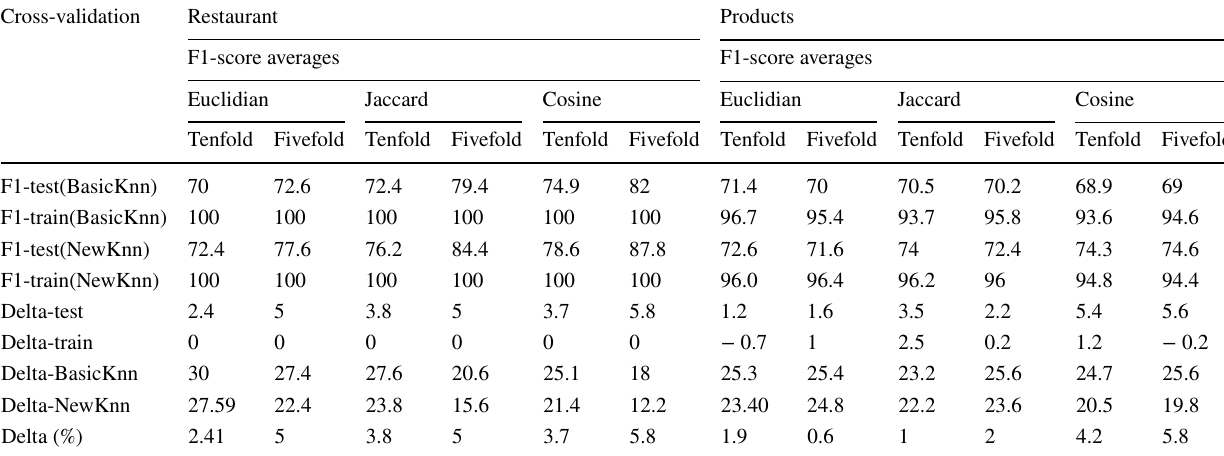
Table 4 F1-score average performances of NewKNN and BasicKNN under Overfitting for both datasets and using three distances